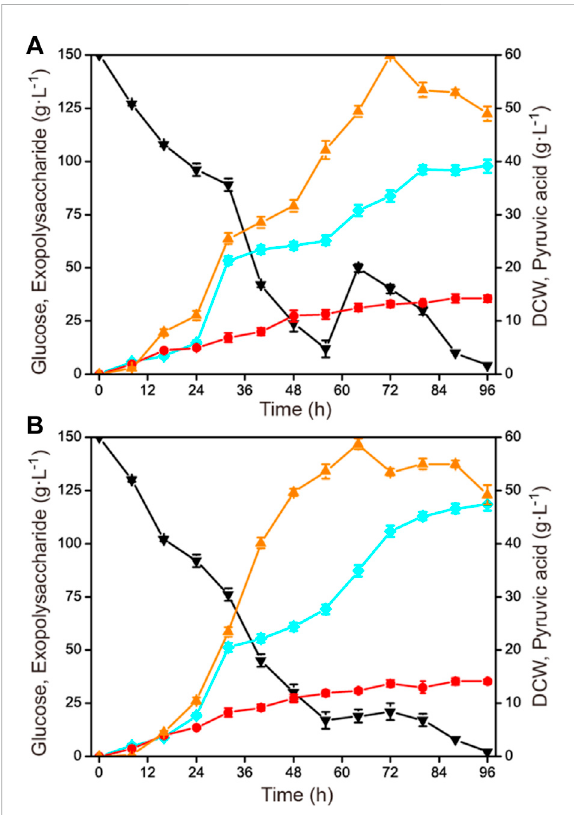
Effects of different feeding strategies on exopolysaccharide production in a 1-L fermenter. The initial concentration of glucose was 150 g L − 1 , and then 40 g L − 1 of glucose was fed with different feeding strategies. (A) One-dose feeding fermentation mode of 40 g L − 1 glucoseat 56 h. (B) Constant rate feeding fermentation mode of 40 g L − 1 glucose during 56 – 84 h. Black down triangles, glucose; orange up triangles, pyruvic acid; red circles, DCW; blue squares,